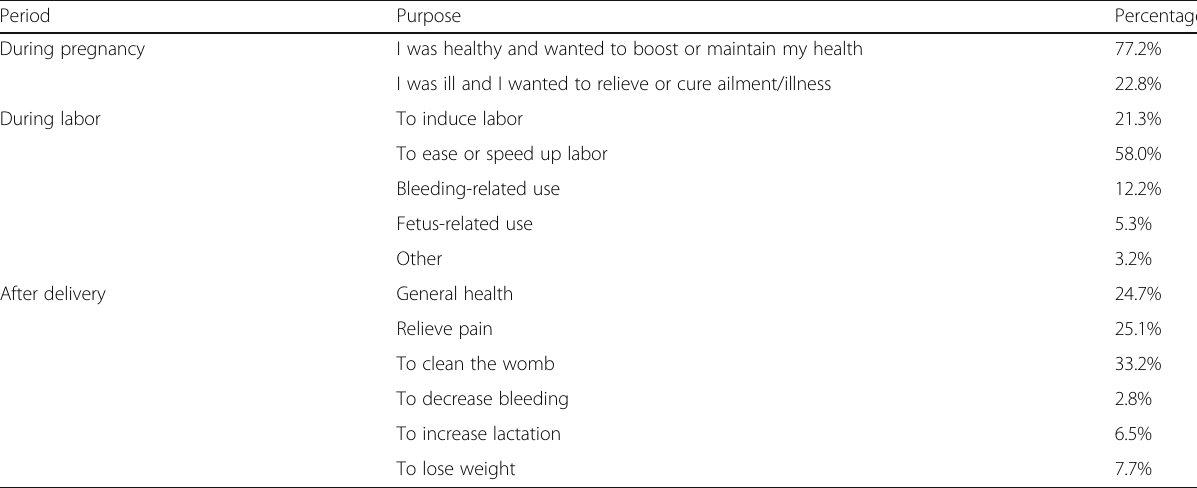
Table 3 Motives behind using herbal medicine during pregnancy, during labor and after delivery